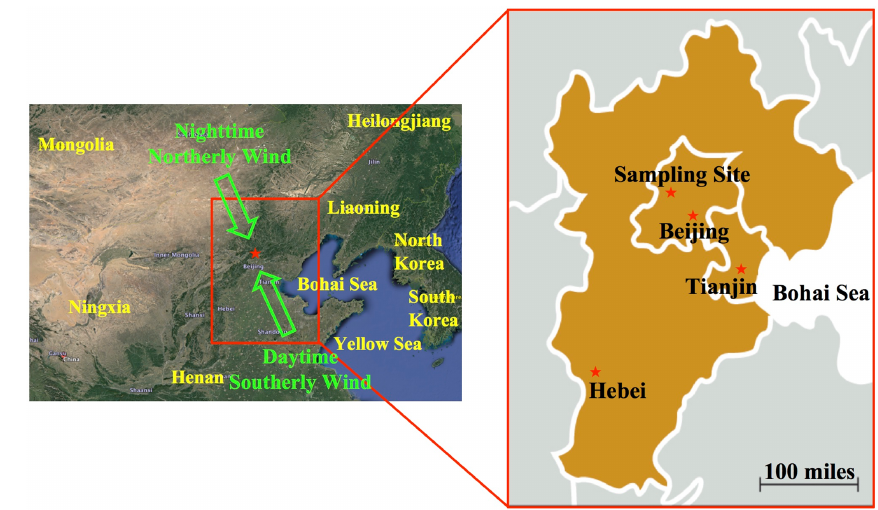
Figure 1. Geographical location of Mangshan, China. The map was downloaded from © Google Maps